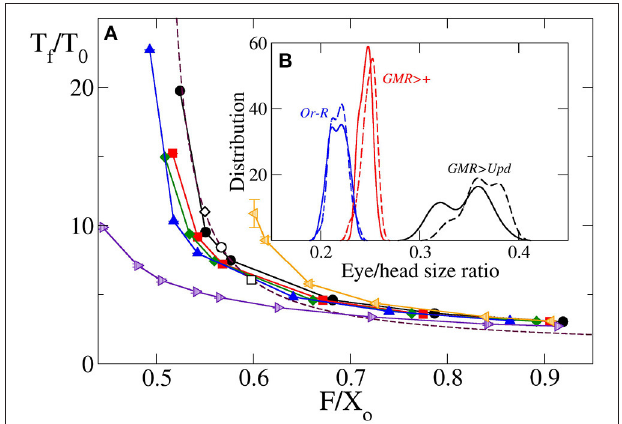
FIGURE 5 | (A) Relative final size of the eye T f / T 0 as a function of ˜ F = F / X 0 obtained by computer simulation for v gr = 2 σ/τ (black line and circles), 4 σ/τ (red line and squares), 6 σ/τ (green line and diamonds) and 10 σ/τ (blue line and triangles). Violet right triangles correspond to oblate primordium with X 0 / Y 0 = 0.540, orange left triangles correspond to prolate primordium with X 0 / Y 0 = 1.923, in both cases with v gr = 6 σ/τ . Symbols are simulation results, and solid lines are guidance for the eyes. Additionally, the universal law Equation (18) is plotted as a maroon dashed line. The values of this relative final size for four Drospila strains calculated using the parameters of Table 1 in Equation (17) are included as open circles for GMR > + , open squares for Or-R and open diamond for GMR > Upd . Note that as ˜ F decreases the relative final eye size increases, and this increase is non-linear. (B) In the inset are plotted measured values of eye head ratio distribution for GMR > Upd (black lines), GMR > + (red lines) and Or-R strains. Solid and dashed lines correspond, respectively, to females and males. The relative standard deviation of these distributions are 0.9, 0.7, and 2.3 for Or-R , GMR > + and GMR > Upd strains, respectively, without significant differences between males and females.